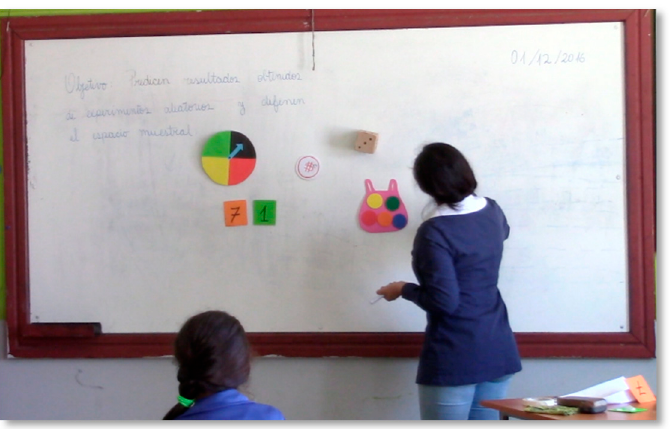
Figure 11. Image capture of 7th grade class.